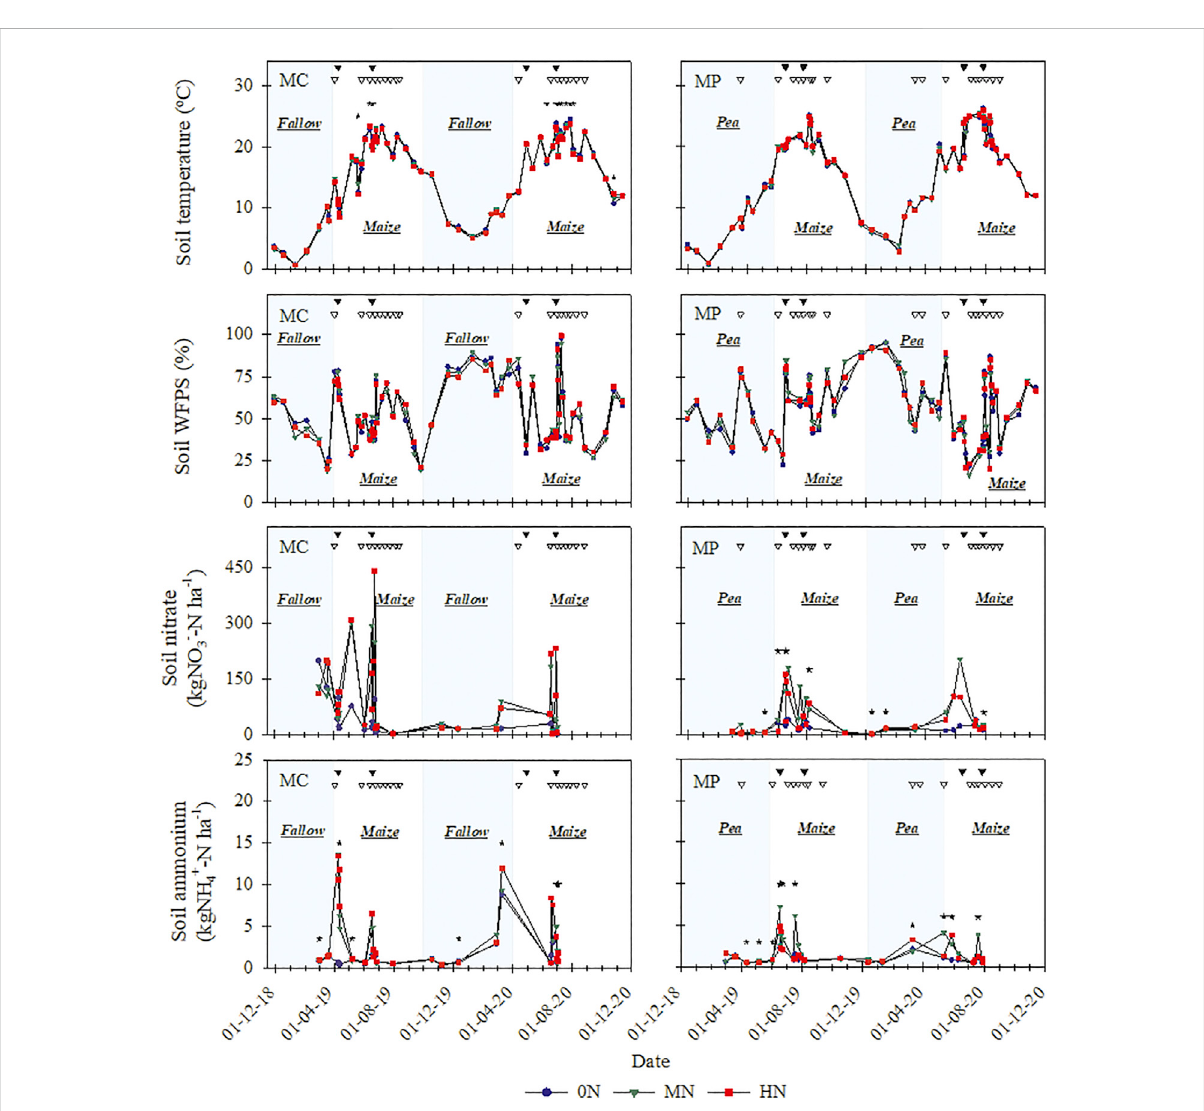
FIGURE 2 Soil temperature at 5 cm depth, soil water- fi lled pore space (WFPS) and soil mineral N content for the 0 – 5 cm soil depth in the maize monoculture (MC) system and the pea-maize (MP) rotation as affected by soil N rate: 0N (unfertilized), MN (medium N rate) and HN (high N rate). *Indicates signi fi cant differences between treatments within a date at p < 0.05. Black triangles indicate fertilizer applications. White trianglesindicate fl ood irrigation